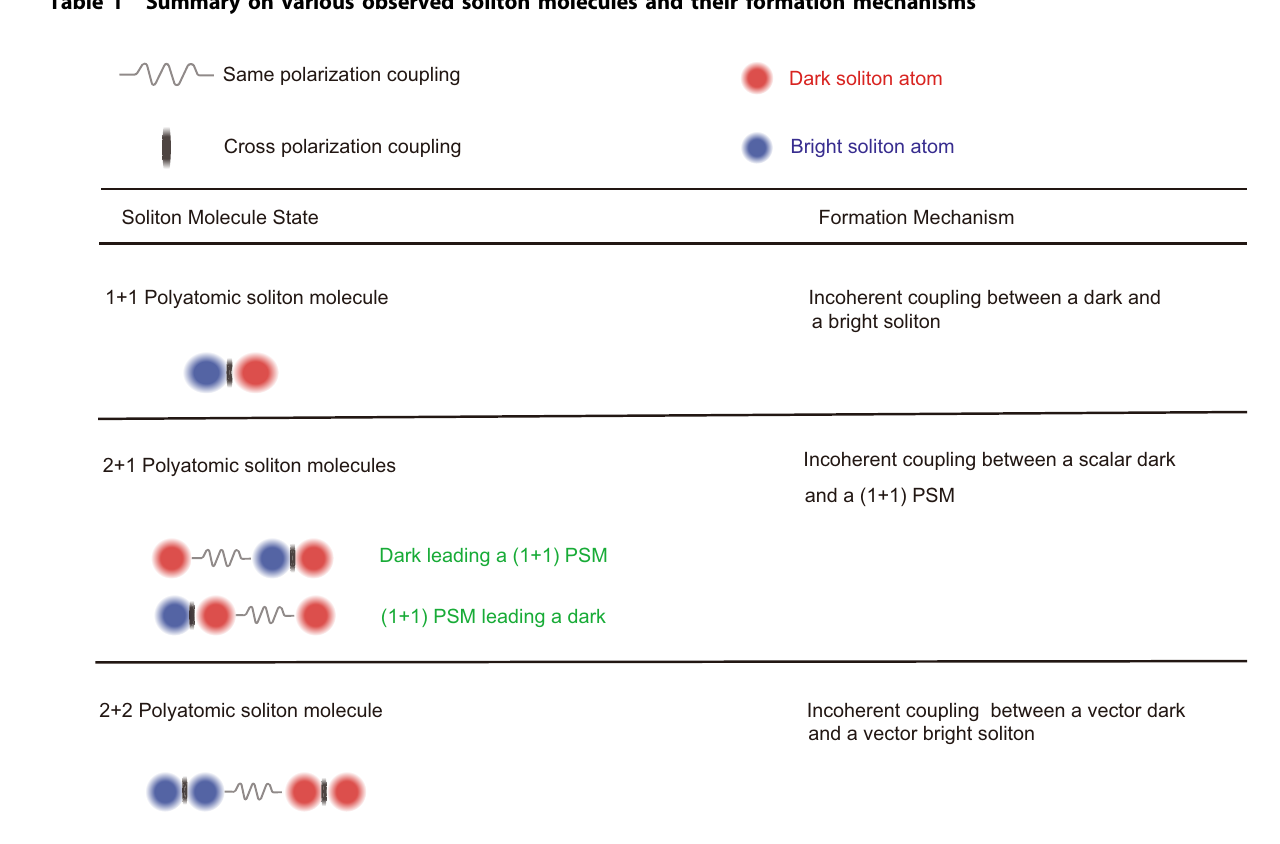
Table 1 Summary on various observed soliton molecules and their formation mechanisms